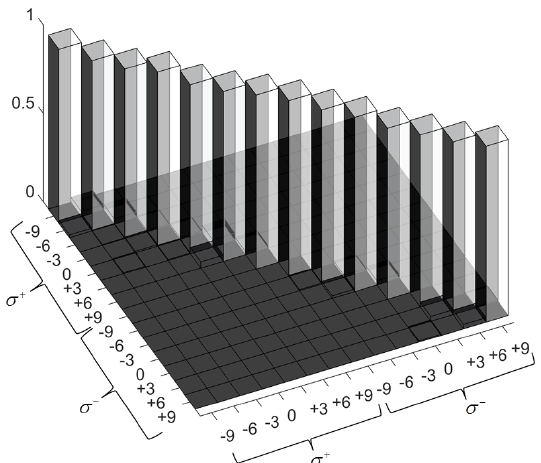
Figure 7. Total intensities in all of the detector regions for OAM mode input in the range {−9, −6, −3, 0, +3, +6, +9} and circular polarization of the experimental data. For each channel, the detection regions have the same size and are chosen to cover the central intensity peak area. Intensities are normalized to the total collected energy. The polarization labels σ ± refers to the polarization state of the input channel (the output is cross-polarized).